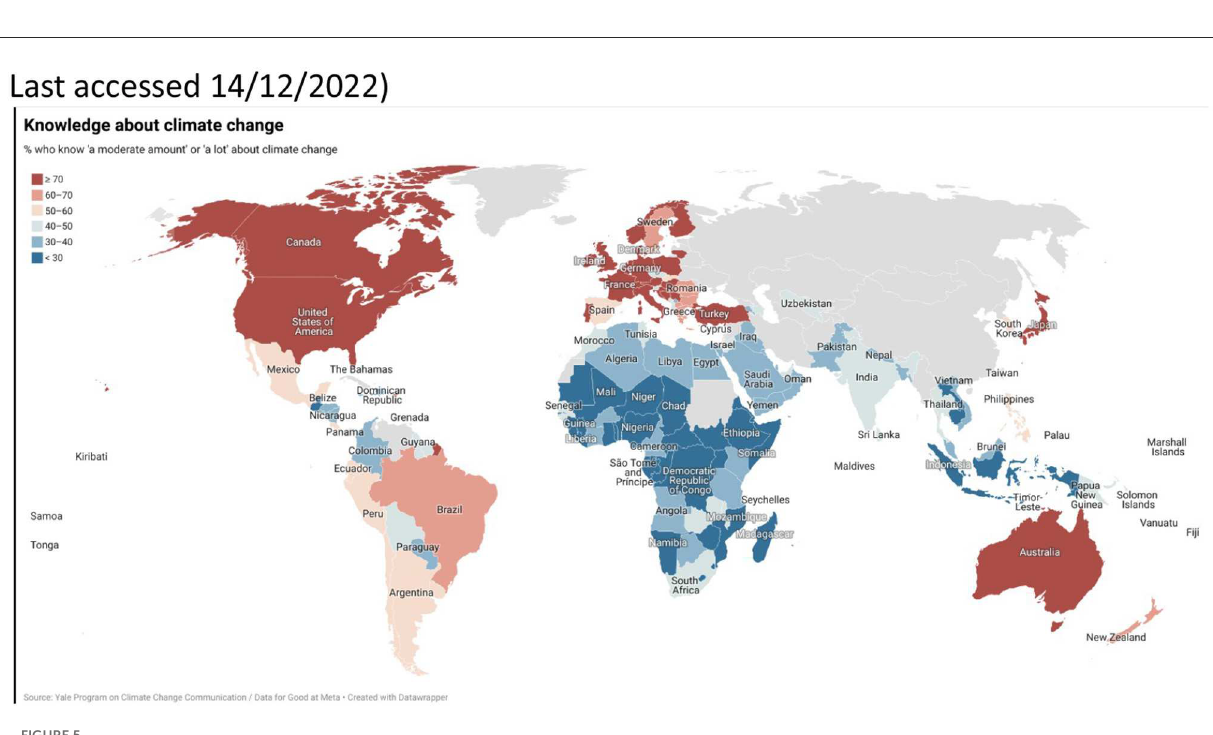
FIGURE5 International public opinion on climate change, 2022. Available online at: https://climatecommunication.yale.edu/publications/international-public- opinion-on-climate-change-2022/toc/3/ (accessed December 15,